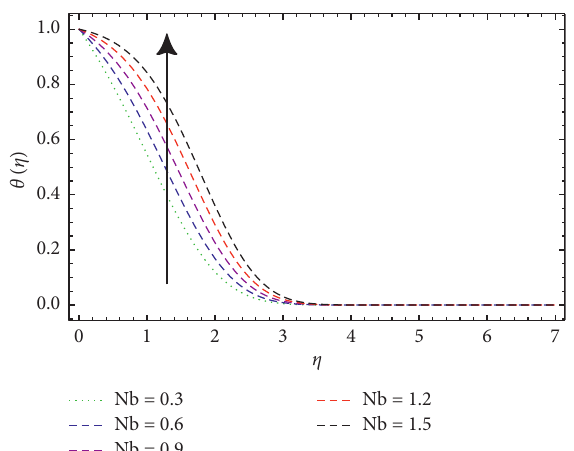
Figure 12: Influence of the θ ( η ) profile via Nb.